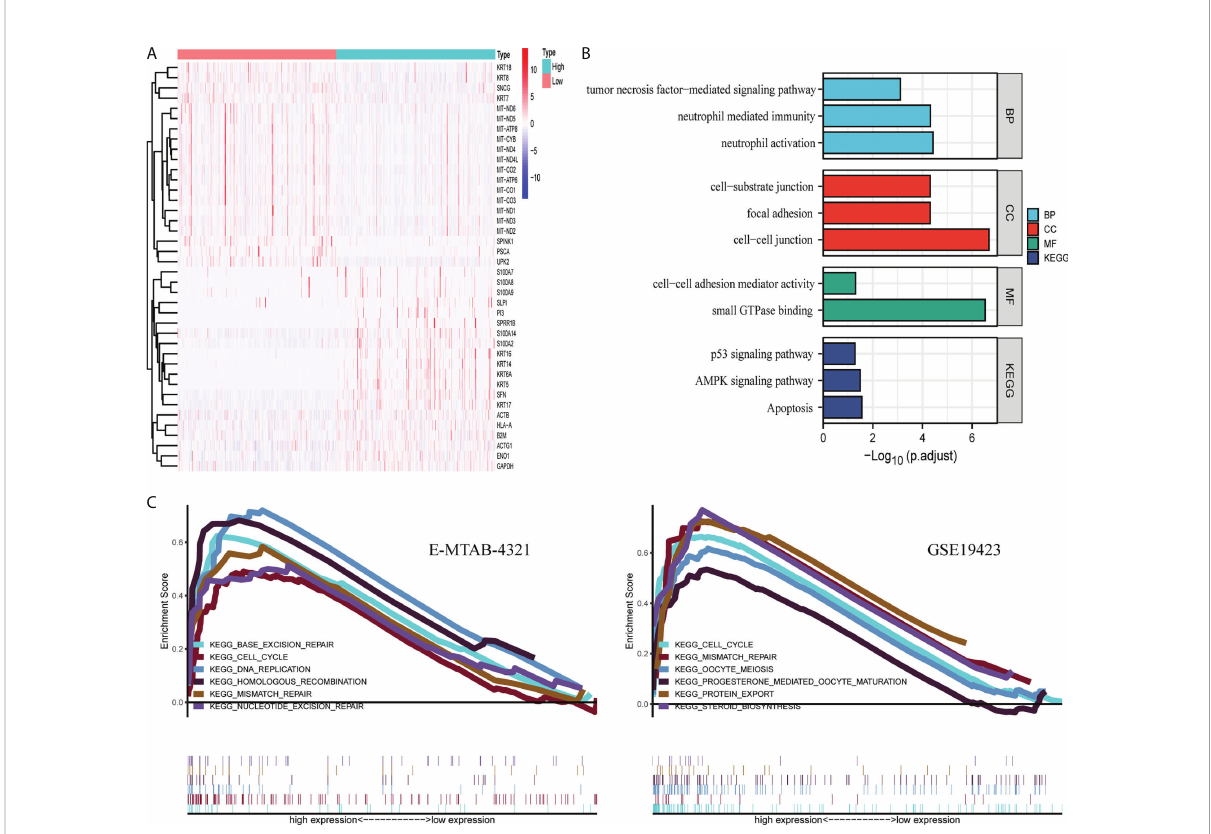
FIGURE 2 Potential biological functions of FGFBP1. (A) The heatmap of DEGs was de fi ned by FGFBP1 in TCGA dataset, p < 0.05. (B) GO and KEGG analyses of DEG were performed in TCGA dataset. (C) GSEA analysis was conducted in high- and low-expression groups divided by the median value of FGFBP1 expression in the E-MTAB-4321 and GSE19432